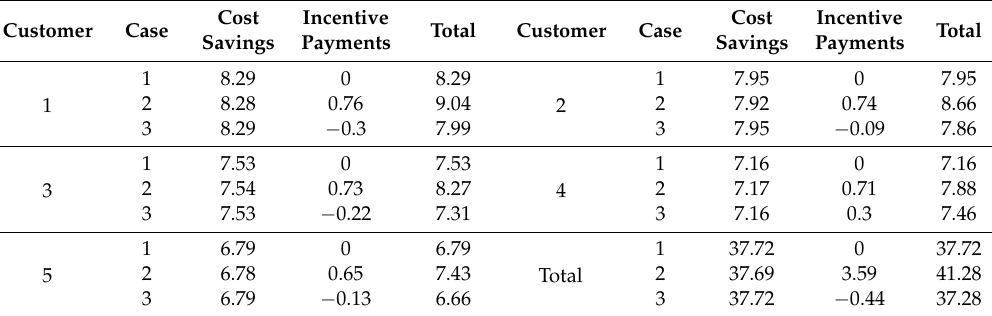
Table A1. Profit of customers on Day 1 (unit: